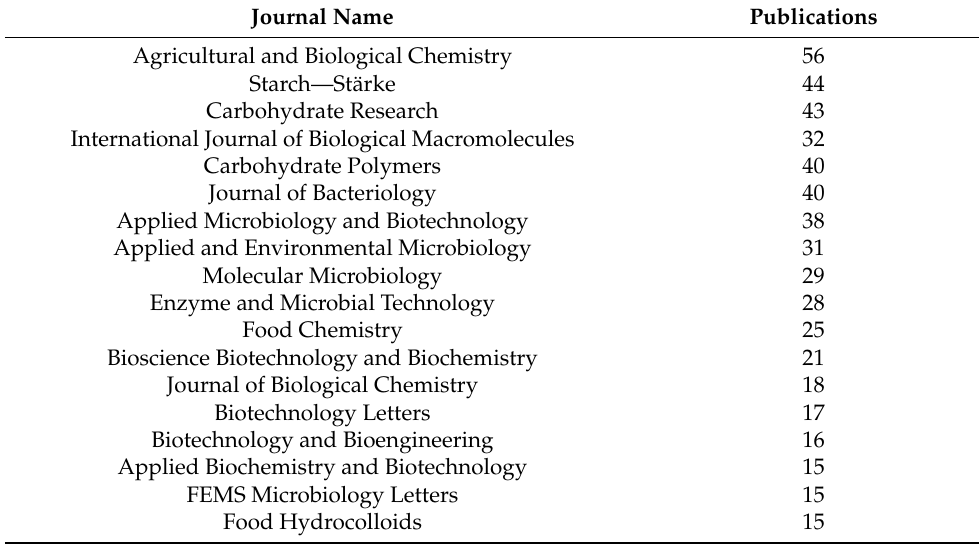
Table 3. Name of journals with more than 15 publications related to pullulan-degrading